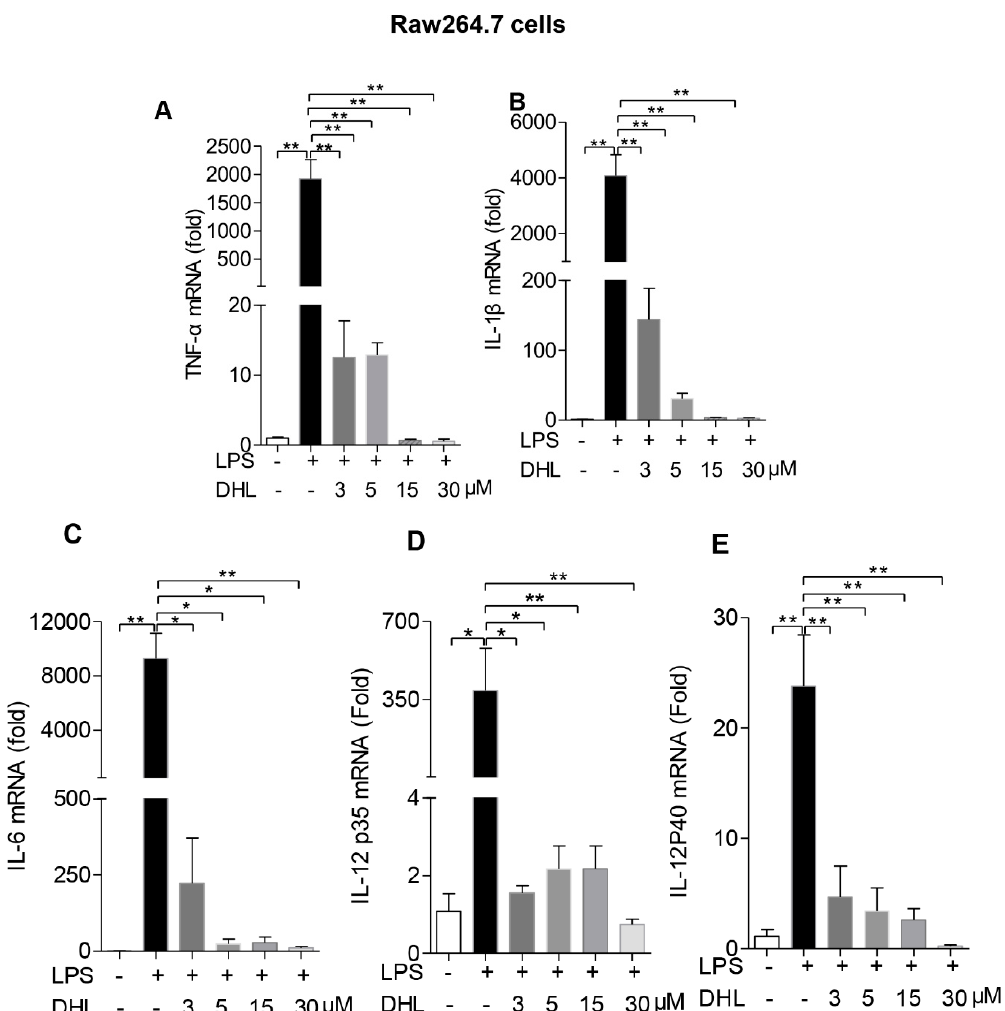
Figure 3. DHL decreased proinflammatory cytokine production in LPS-stimulated RAW264.7 cells. RAW264.7 cells were pre-treated with 0, 3, 5, 10 and 30 μ mol/L DHL for 0.5 h before LPS (100 ng/mL) for 24 h, cells were collected to isolate total RNA, the mRNA expression level of ( A )TNF- α , ( B ) IL-1 β , ( C ) IL-6, ( D ) IL-12 p35 and ( E ) IL-12 p40 were measured by quantitative PCR. Values represent means ± SEM, * p < 0.05 and ** p < 0.01.